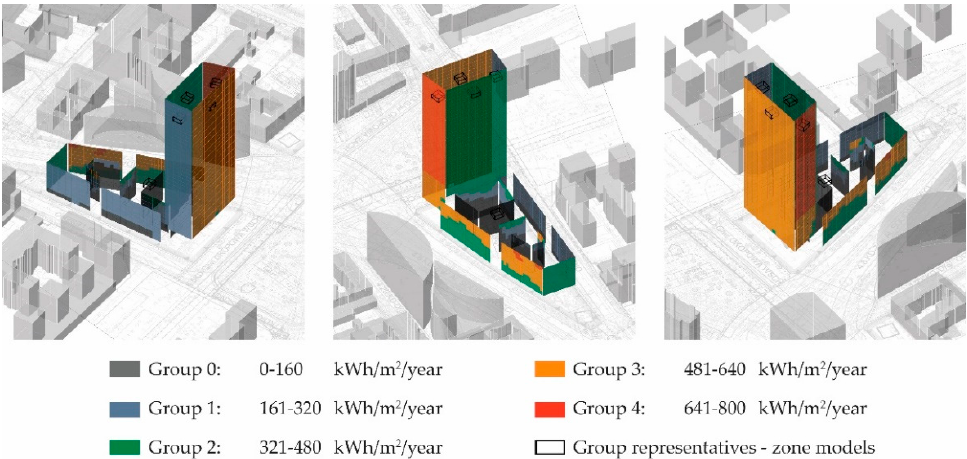
Figure 12. Accepted division into groups based on the annual value of sunlight radiation received by the elevation modules.